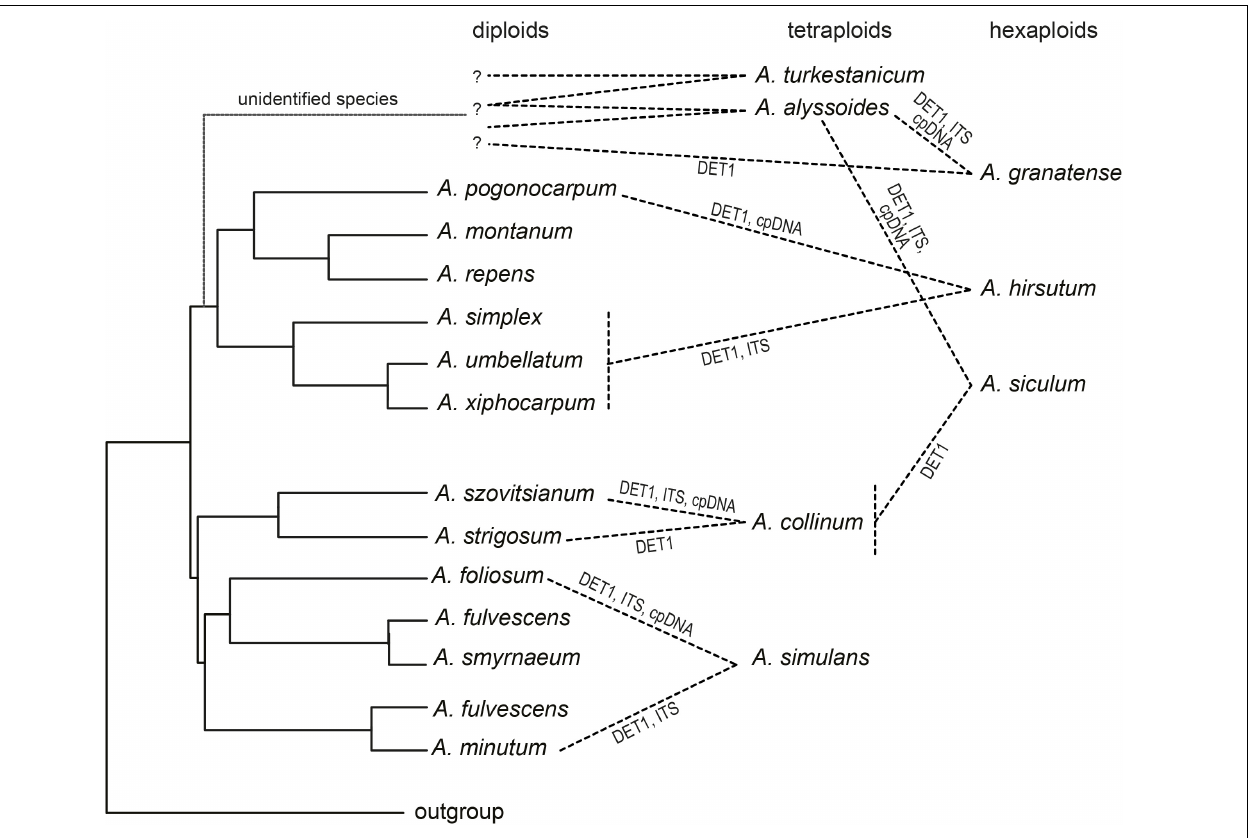
FIGURE 8 | Scheme summarizing the allopolyploidization events in the studied Alyssum species, as inferred from DNA sequence data. Diploid species are depicted in the coalescent species tree, as shown in Figure 7A , based on all three markers used, whereas polyploids are connected to their inferred diploid or lower-ploidy progenitors. Question marks indicate unidentified diploid progenitors (species currently not occurring in Europe, possibly of Asian origin or extinct). See the text for further